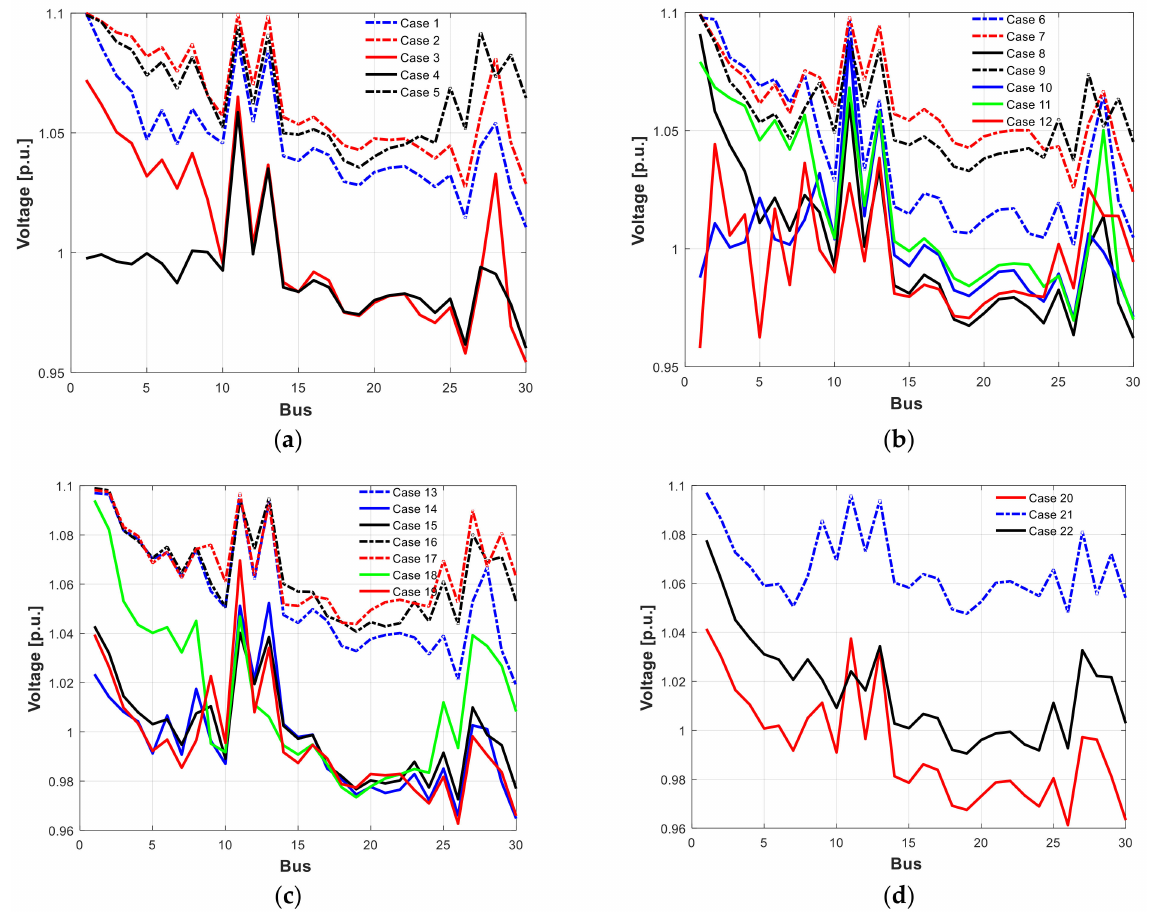
Figure 8. The voltage profile for single- and multi-objective optimal power flow on the IEEE 30-bus test system. ( a ) Single OF, ( b ) Bi OF, ( c ) Tri OF, ( d ) Quad and Quinta